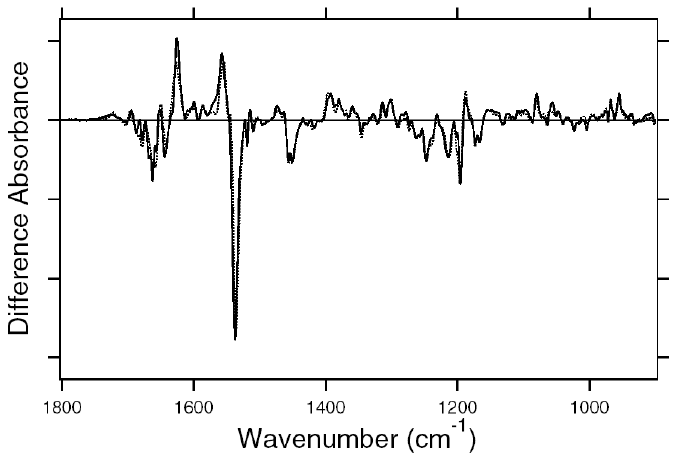
Figure 32. The full-length (solid line) and truncated (dotted line) ASR (pH 7) in the 1,800–900 cm -1 region. The spectra are measured at 170 K upon hydration with H O. One division of the y-axis corresponds to 0.004 absorbance units. This figure is 2 reprinted with permission from Kawanabe et al [77]. Copyright 2008 American Chemical